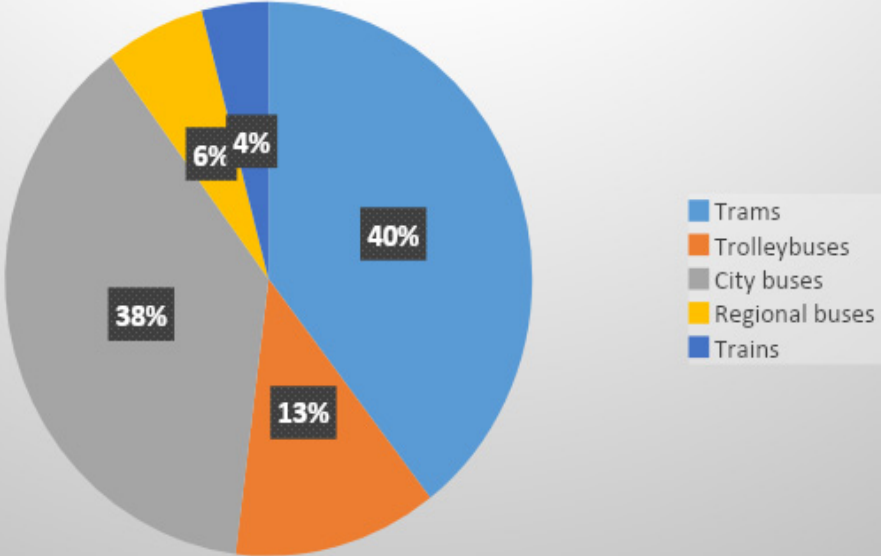
Figure 3. Brno share of public transport vehicles by the end of 2019 based on DPMB data—prepared by authors [43,54,55].